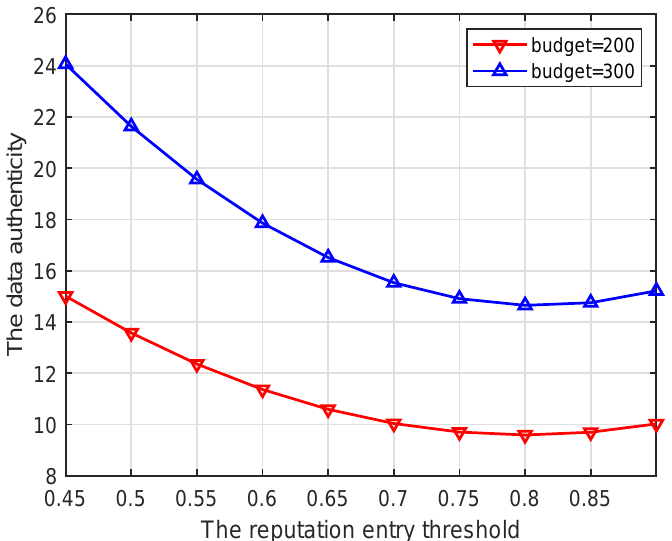
Figure 9. Entry threshold vs. Data